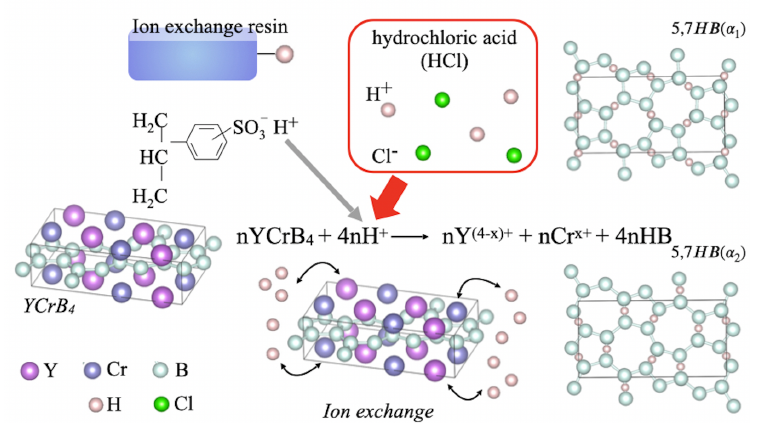
Figure 1. Concept of the synthesis of HB sheets with the 5- and 7-membered rings (5,7-HB) from a YCrB 4 crystal through the addition of hydrochloric acid